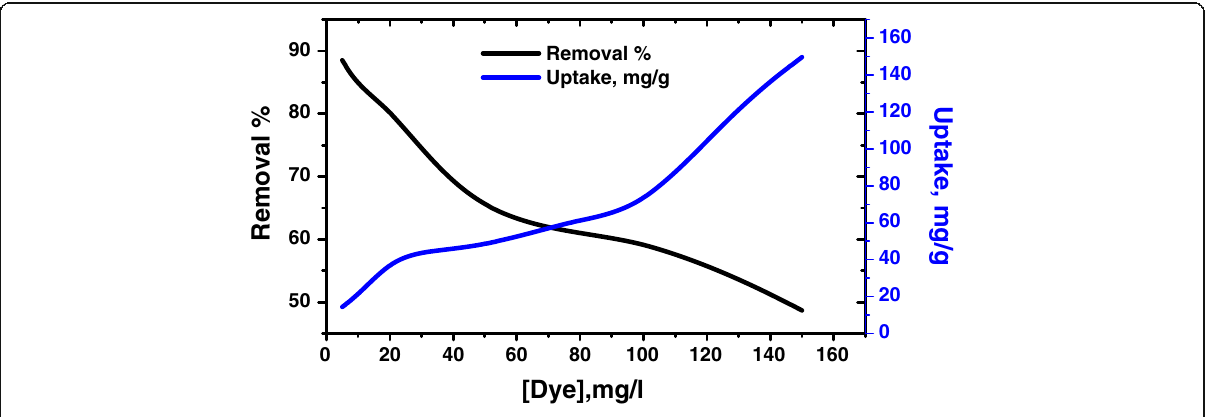
Fig. 7 Effect of initial dye concentration on adsorption of AO67